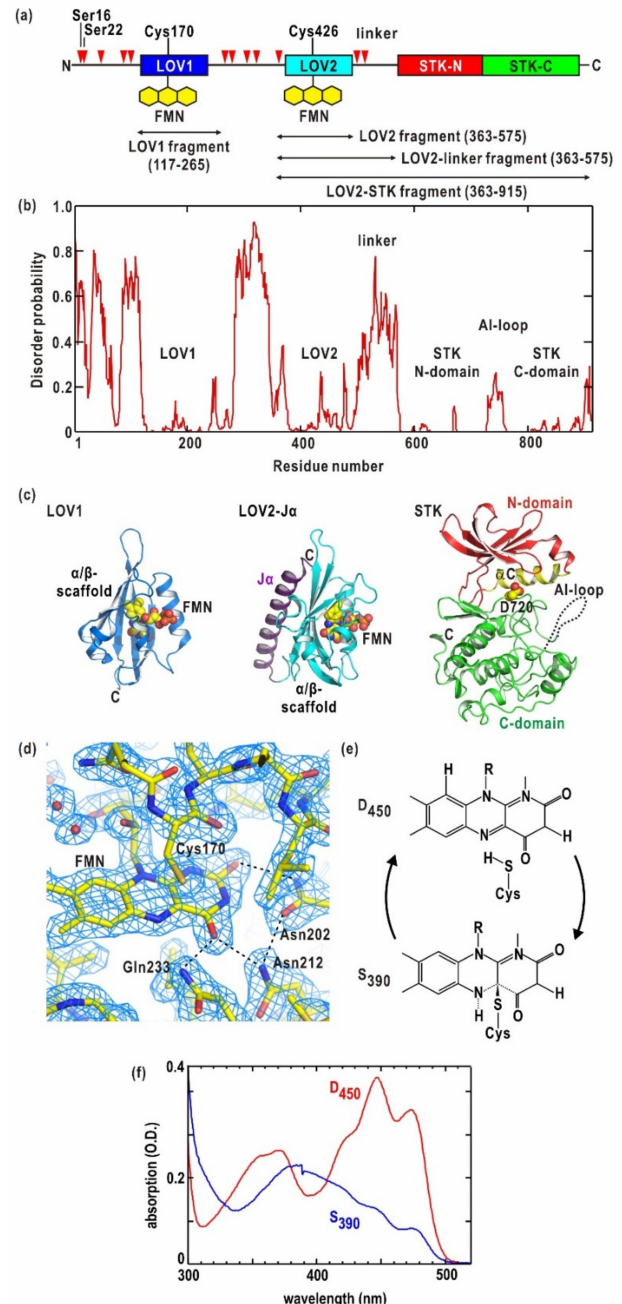
Figure 1. ( a ) The domain organization in Arabidopsis phot2. Fragments used in SAXS experiments are indicated. The red triangles denote phosphorylation sites. Some residues are labeled. ( b ) Disorder probability calculated by the DISOPRED2 program [41] plotted against residue number. Regions fold into functional domains and loops are labeled. ( c ) Protomer of LOV1 dimer (Protein Data Bank